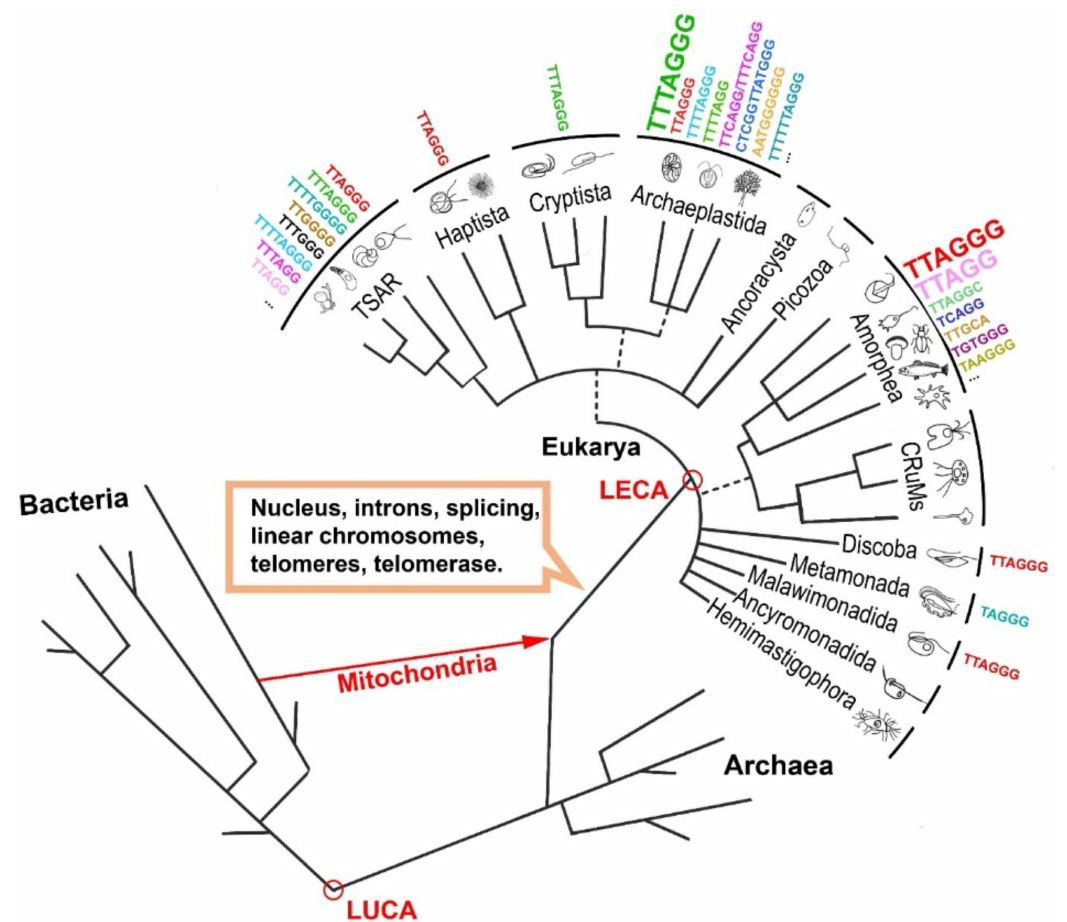
Figure 2. Telomeres and telomerase in the evolutionary tree. A simplified phylogenetic tree is shown, where telomeres and telomerase evolved upon linearization of chromosomes by the insertion of Group II self-splicing introns [37]. In the Eukaryote branch, the groupings correspond to the current ‘supergroups’ according to the recent eukaryotic Tree of Life (eToL) [24]. Unresolved branching orders among lineages are shown as multifurcations. Broken lines reflect lesser uncertainties about the monophyly of certain groups. Examples of known telomeric repeat variants are listed next to respective supergroups (see also Table S1). The major known telomeric repeat variants in the supergroups are marked with a larger font [22,36,38] (see text for details). Last eukaryote common ancestor (LECA); last universal common ancestor (LUCA); telonemids, stramenopiles, alveolates and Rhizaria (TSAR); collodictyonids, Rigifilida, Mantamonas (CRuMs). The living species icons are partly adopted from Adl et al., 2012